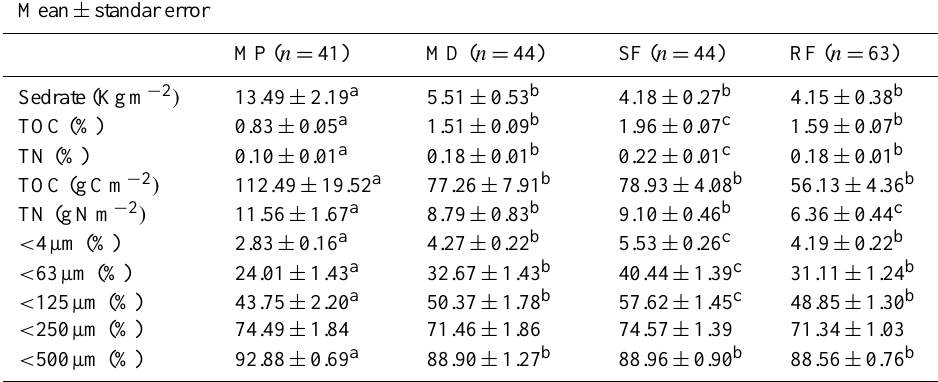
Table 2. One-way ANOVA summary results for deposited sediment variables, grouped by study site. All variables presented significant differences except the < 250µm particle-size. Superscript letters (a,b,c) within a row indicate the sub-groups formed after the applied post- hoc comparisons (SNK or Tahmane Test, p < 0 . 05).